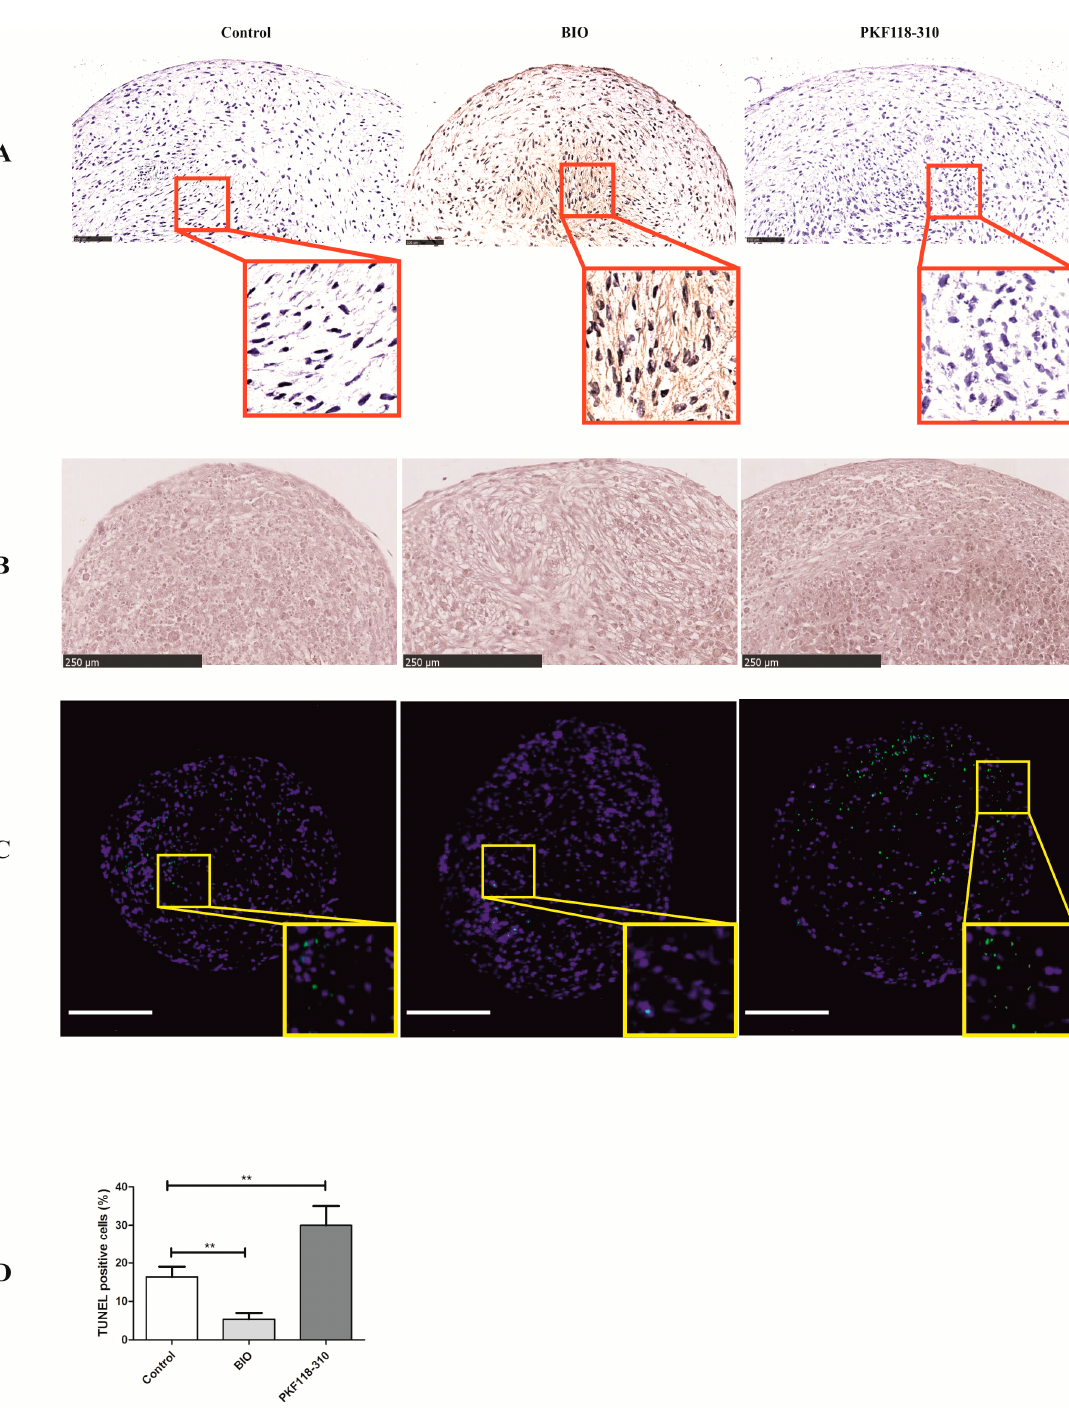
Figure 5. The effects of BIO or PKF on the hypertrophy, mineralization, and apoptosis of hMSCs pellets. ( A ) Immunohistochemistry of Collagen type X. The Collagen type X was detected by mouse anti-human Collagen type X antibody. Cell nuclei were counterstained with hematoxylin. Images were taken using a Nanozoomer. Scale bar = 100 µm; ( B ) Alizarin red staining for matrix mineralization. Scale bar = 250 µm; ( C ) TUNEL assay. Positive apoptosis cell (green) was stained using the DeadEnd Fluorometric TUNEL System. Nuclei were counterstained with Hoechst 33342 (blue). Scale bar = 500 µm; ( D ) Quantification of apoptotic cells. ** p < 0.01. Error bars represent SD.